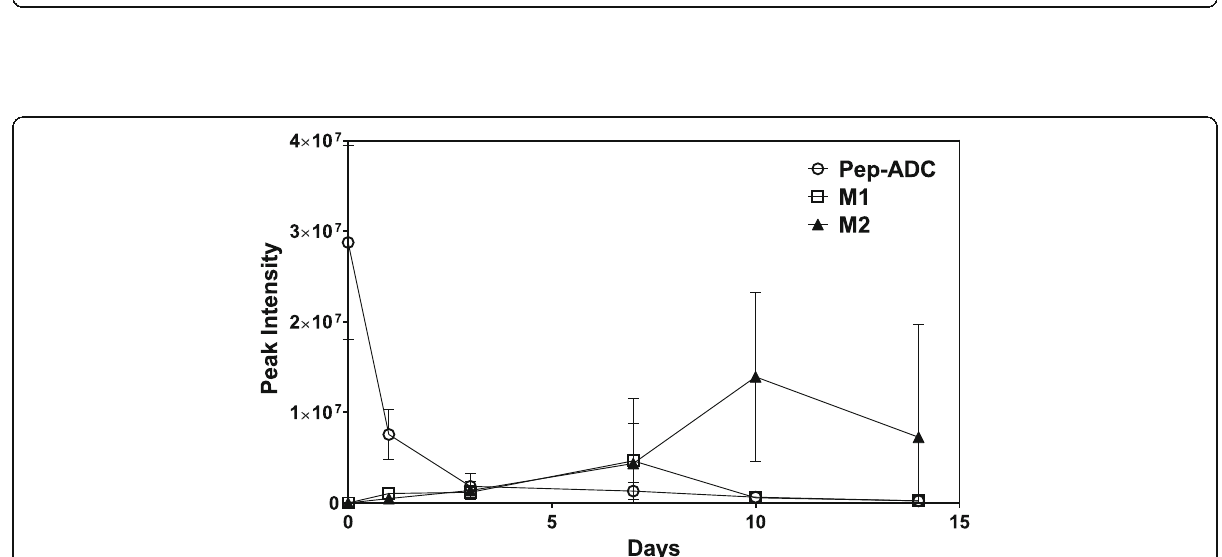
Fig. 11 Intact mass analysis of Pep-ADC by AP-LC-MS in non-human primates. Rhesus monkeys ( n = 3) were dosed IV with a single 3 mg/kg Pep- ADC dose. Pep-ADC in dosed plasma samples at indicated time points was retrieved by pull-down for intact mass analysis on a Synapt G2S Q- TOF. Relative abundance of intact Pep-ADC and main metabolites (M1 and M2) is depicted by plotting average peak intensity for up to 14 days after dosing. Data plotted are mean peak intensity from three animals per time point. Error bars correspond to the S.D. calculated using GraphPad Prism 7. Error bars shorter than the symbols are not